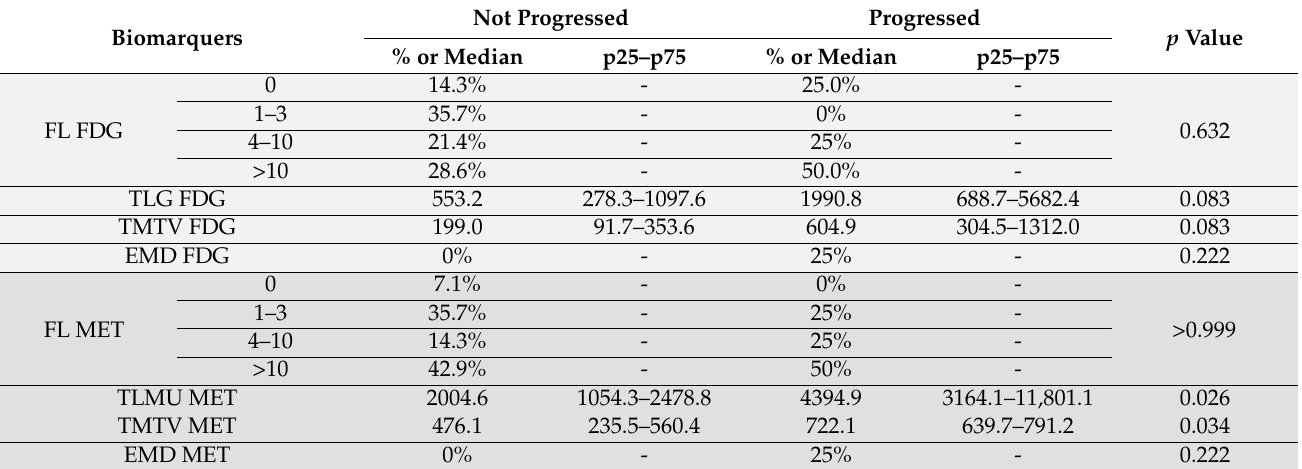
Table 4. Baseline FDG and MET parameters in NDMM according to clinical outcome